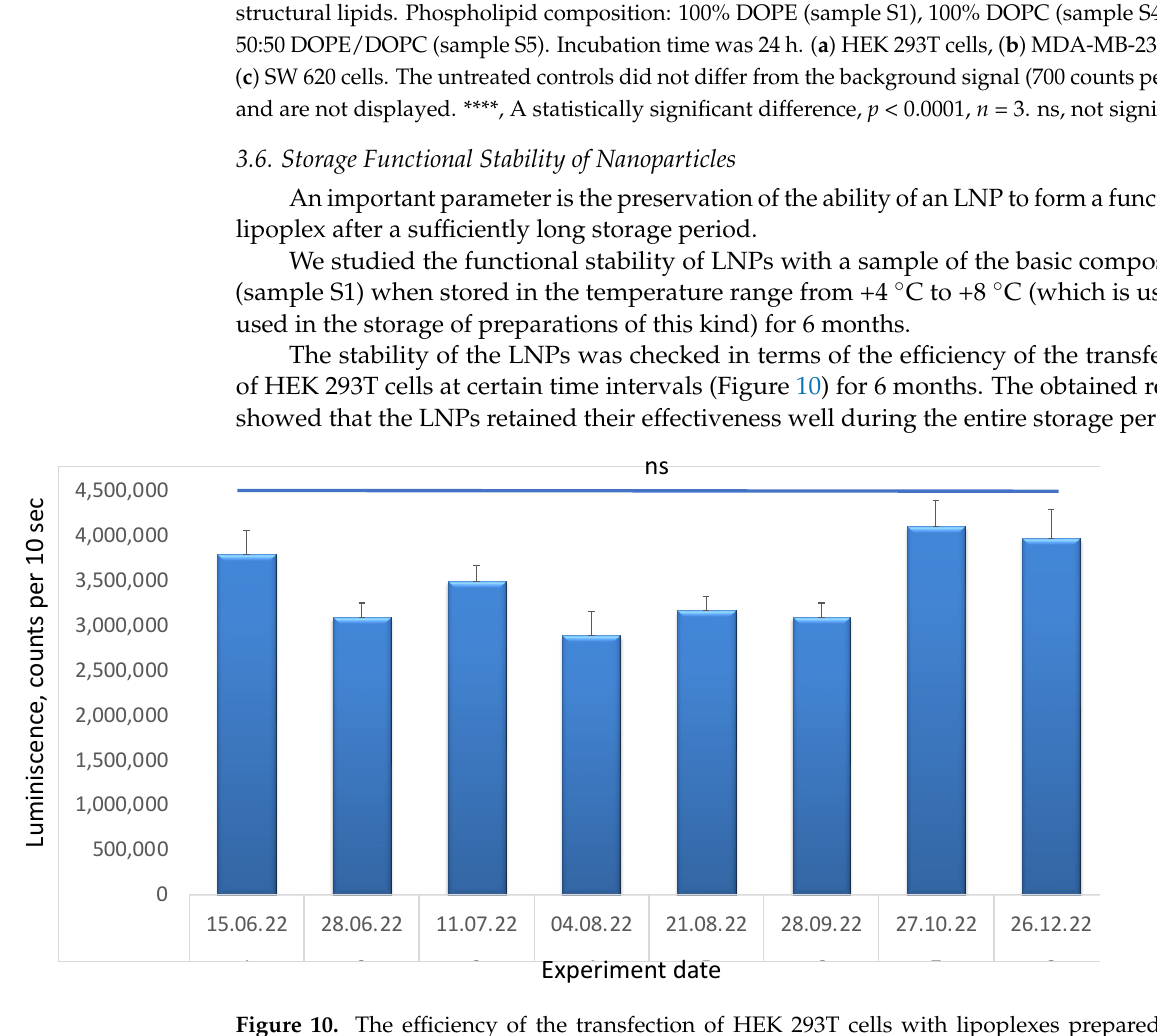
Figure 10. The efficiency of the transfection of HEK 293T cells with lipoplexes prepared from nano- particles of the base composition (sample S1) stored at +4–8 °C. Incubation time was 24 h. ns. not significant, n = 3.